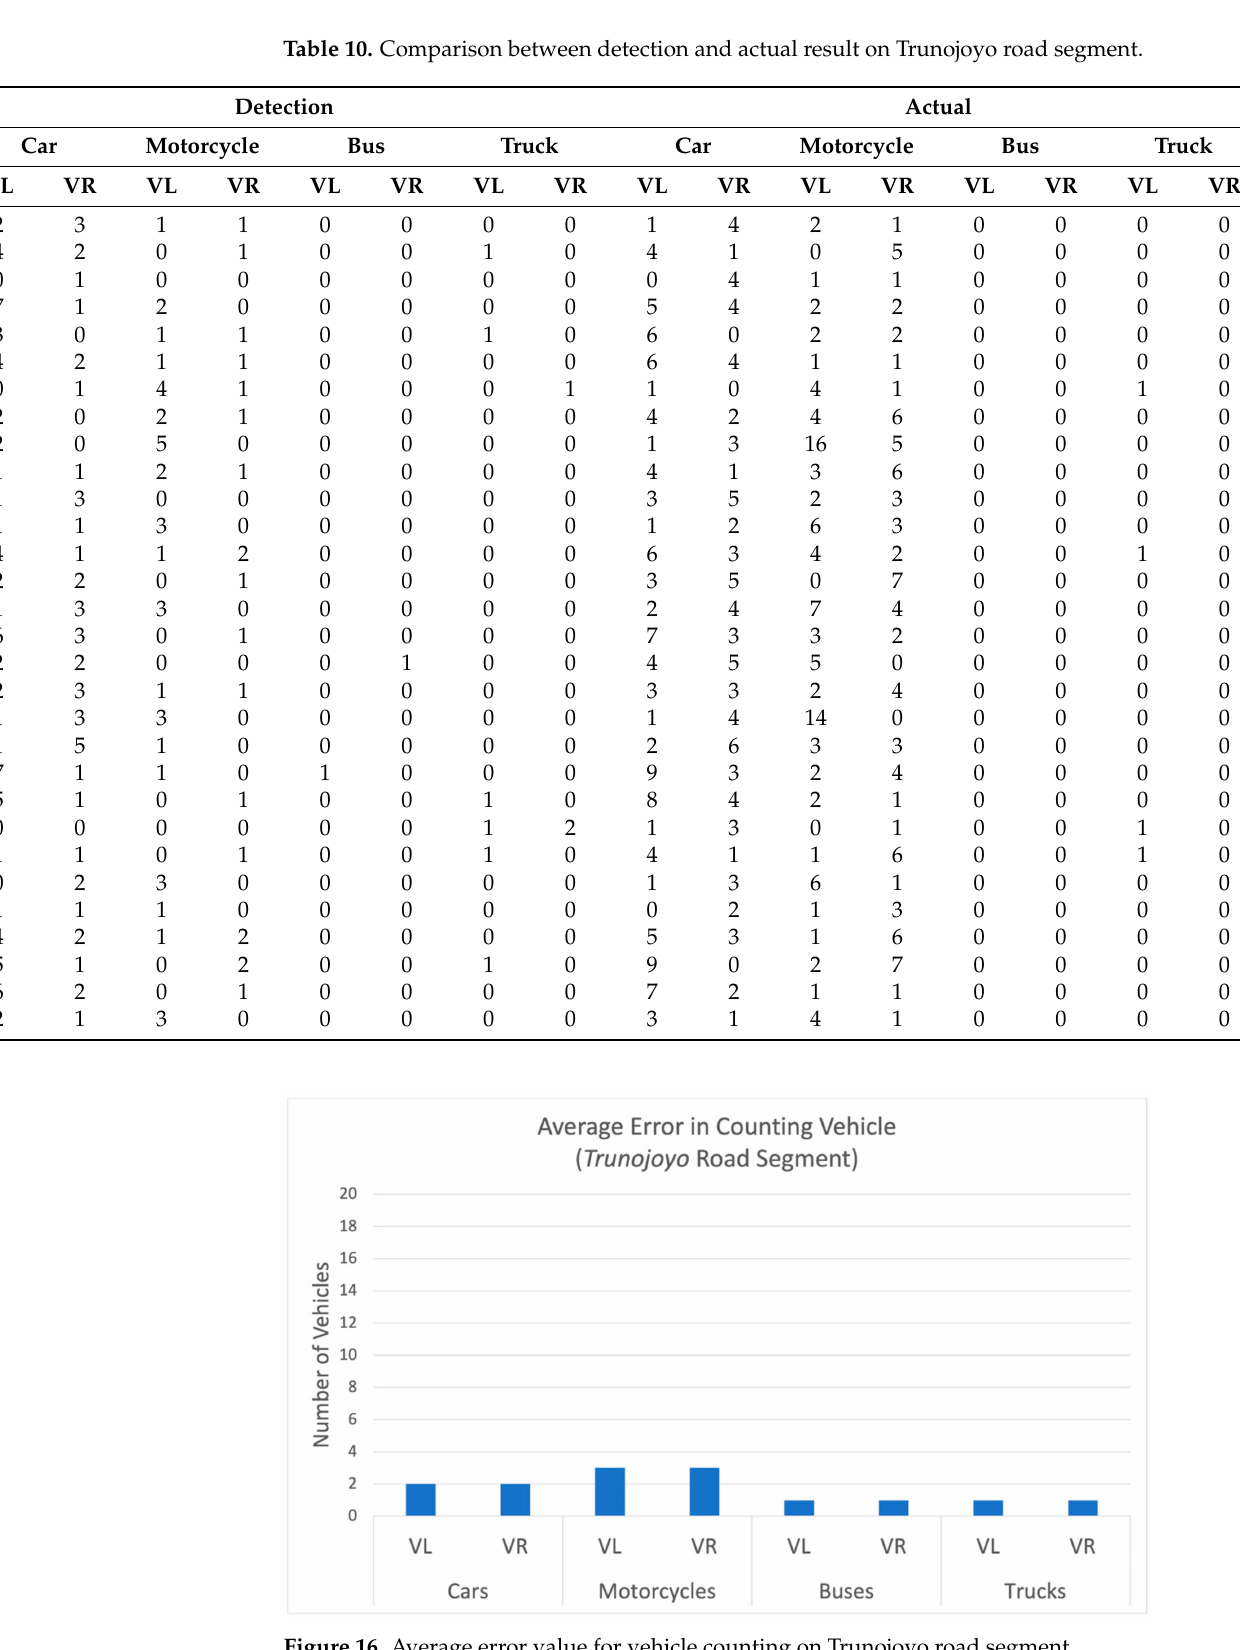
Figure 16. Average error value for vehicle counting on Trunojoyo road